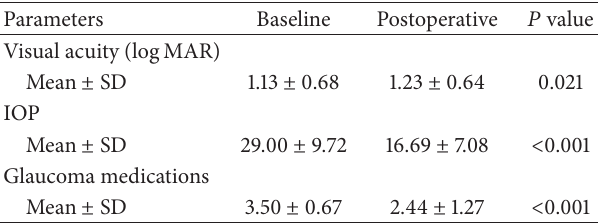
Table 2: Comparison between baseline and postoperative visual acuity, intraocular pressure, and glaucoma medications.